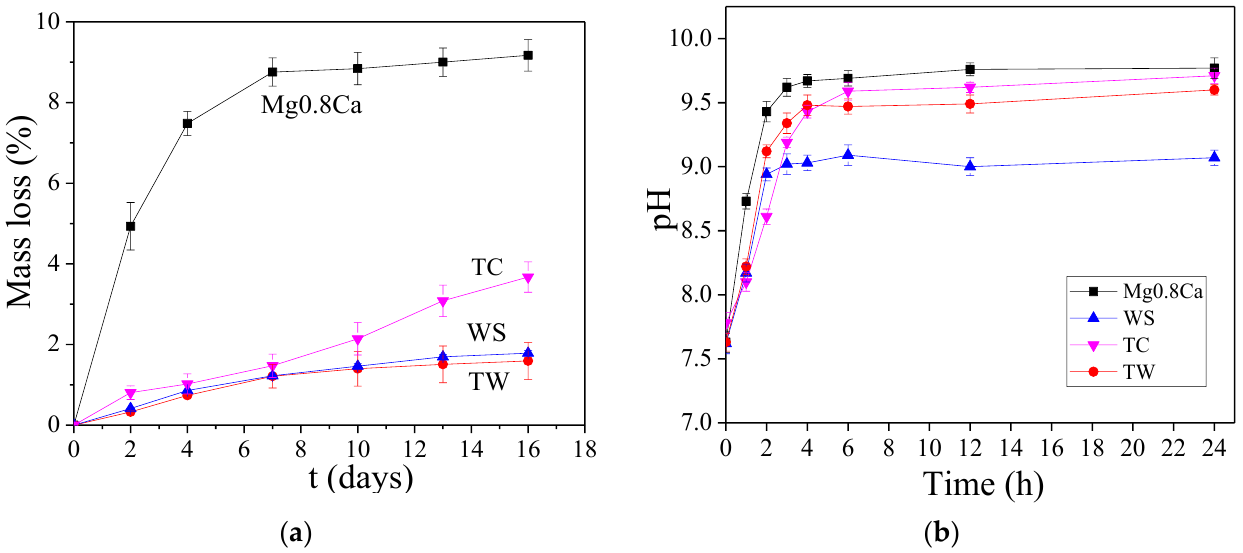
Figure 14. Graphs of the mass loss over time ( a ), kinetics of pH changes in the cell medium during interaction with the samples ( b ).